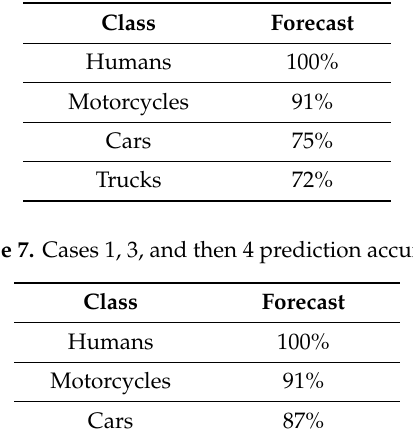
Table 6. Cases 1 and then 2 prediction accuracy.